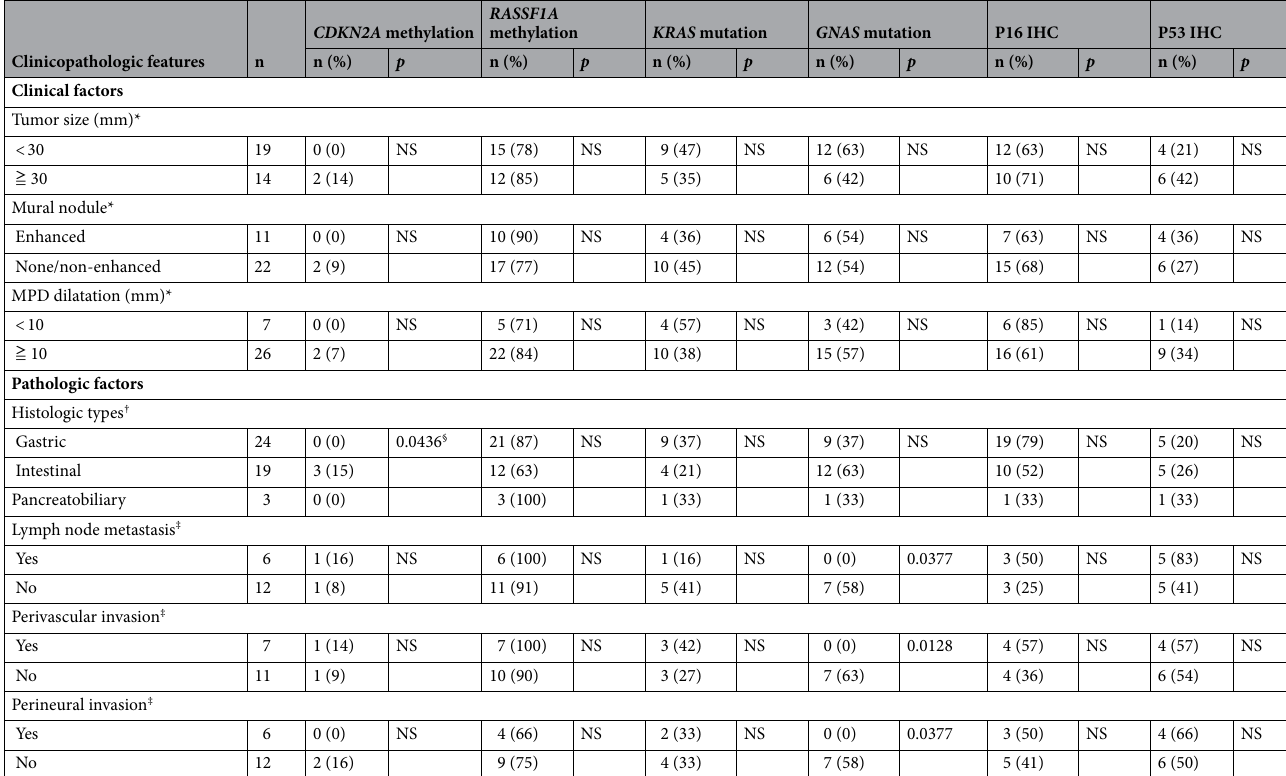
dissected regions, CDKN2A methylation was more frequent in intestinal-type dissected regions than in gastric- type dissected regions (15% vs. 0%; p = 0.0436). Among the malignant-potential IPMN dissected regions, GNAS mutation was less frequent among those with perivascular invasion compared to those without (0% vs. 63%, p = 0.0128), dissected regions with perineural invasion (0% vs. 58%; p = 0.0377), or dissected regions exhibiting without a GNAS mutation (undefined days vs. 1004 days; p = 0.0419) (Fig. 5). The Histopathologic type of IPMN did not affect the prognosis of malignant-potential IPMN. RASSF1A methylation, LINE-1 methylation, KRAS mutation, and BRAF mutation status as well as the P16, RASSF1, and P53 positivity rates according to IHC did not differ significantly across clinicopathological parameters. Methylation and mutation differences in two dissected regions from the same case. To explore malignant initiation and transformation, the methylation and mutation status was compared between malignant-potential IPMN (IC-IPMN and HG-IPMN) and benign A-IPMN dissected regions obtained in pairs from 11 IC-IPMN and 2 HG-IPMN cases (Table 3). Overall, 5 out of 13 (38%) malignant-potential dissected regions harbored the same KRAS and GNAS mutations. Cases harboring concordant sequences of KRAS and